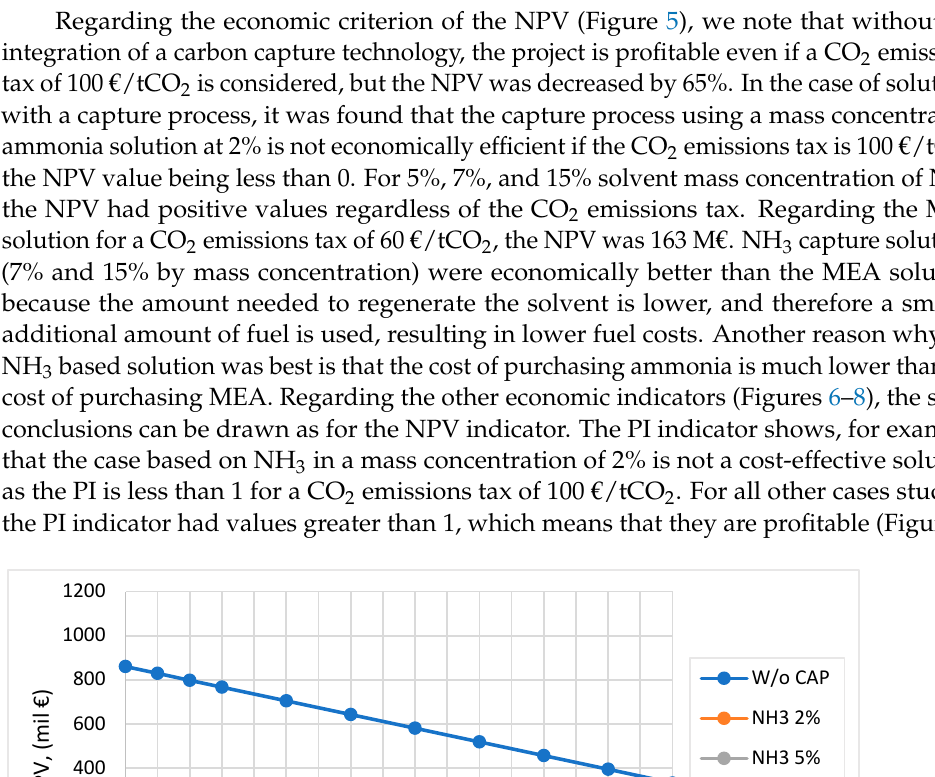
Figure 6. IRR with and without the CO 2 capture process according to the CO 2 emissions tax.